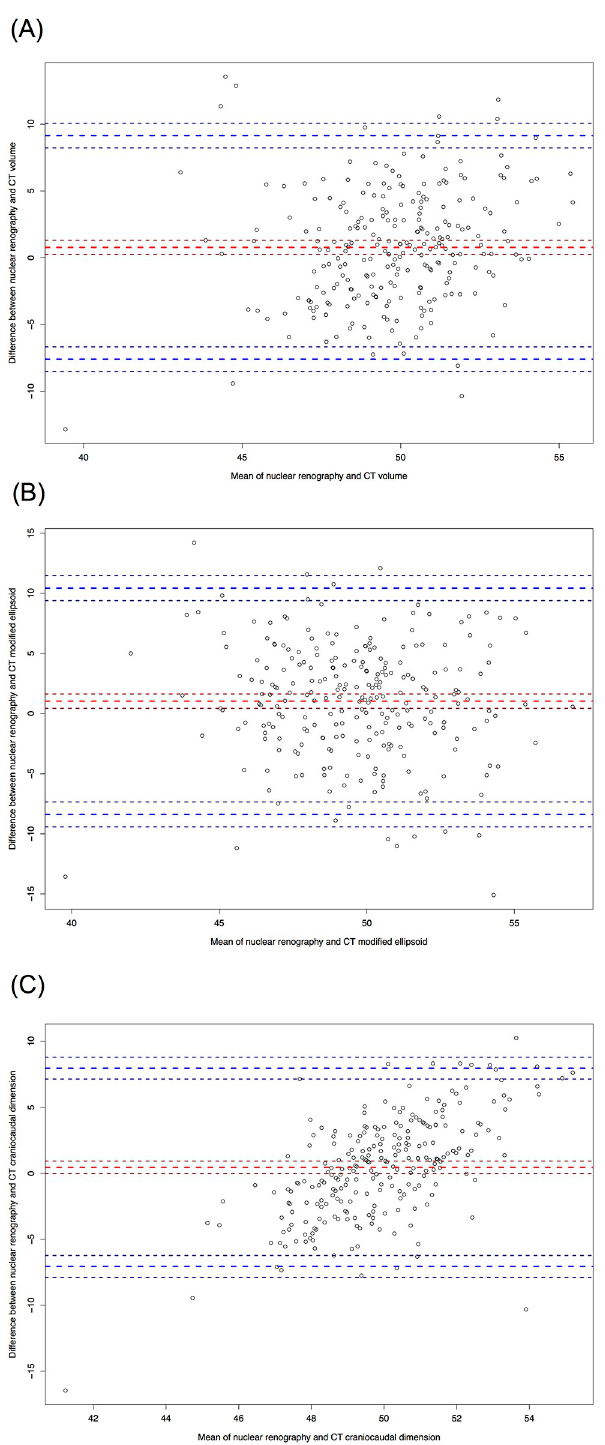
Fig 4. A–C. Bland Altman plots of agreement of split kidney function measured by nuclear renography versus CT based measurements. Nuclear renography based measurements versus A) CT volume with mean bias, (thick red perforated line) & 95% limits of agreement (thick blue perforated lines) of 0.76%, -7.60–9.15%, B) CT modified ellipsoid 1.01%, -8.38–10.42%, and C) CT craniocaudal dimension 0.44%, -7.06–7.94, n = 248. Thin perforated lines represent standard